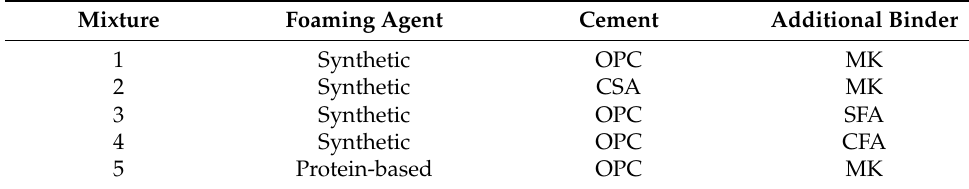
Table 4. The tested foam concrete mixtures.